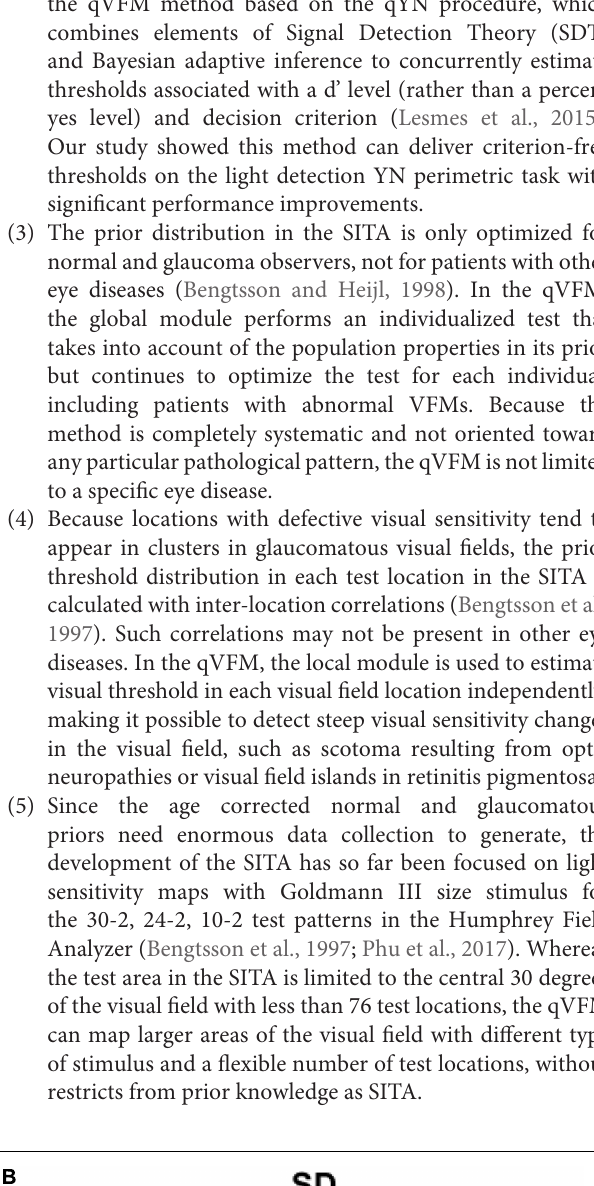
Frontiers in Neuroscience |